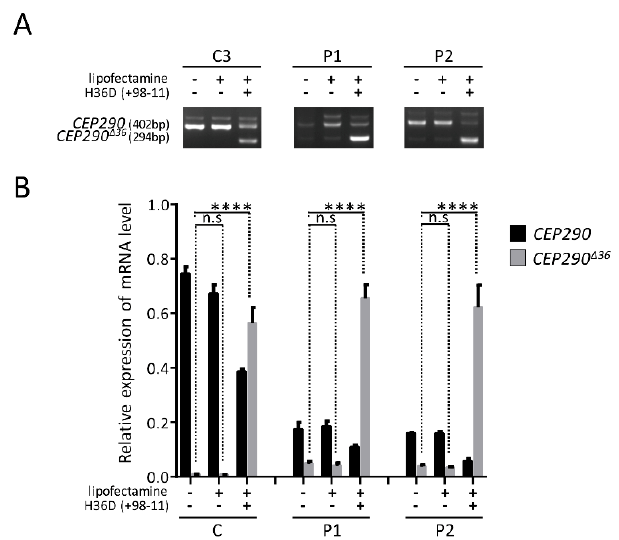
Figure 7. Effect of AON-mediated exon 36 skipping on CEP290 mRNAs. ( A ) RT-PCR analysis of CEP290 transcripts expressed in control (C3) and patient (P1 and P2) fibroblasts untreated or treated for 24h with lipofectamine alone or associated to H36D AON. Images of agarose gel showing amplicons produced using primer pairs surrounding mutant exon 36. ( B ) Relative expression levels of full-length (black bars) and exon 36-skipped (grey bars) CEP290 mRNAs in control (C1–C3) and patient (P1 and P2) fibroblasts as determined by RT-qPCR. Bars show the mean ± SEM from three independent experiments. C represents the pooled values of C1–C3. **** p ≤ 0.0001, n.s., not